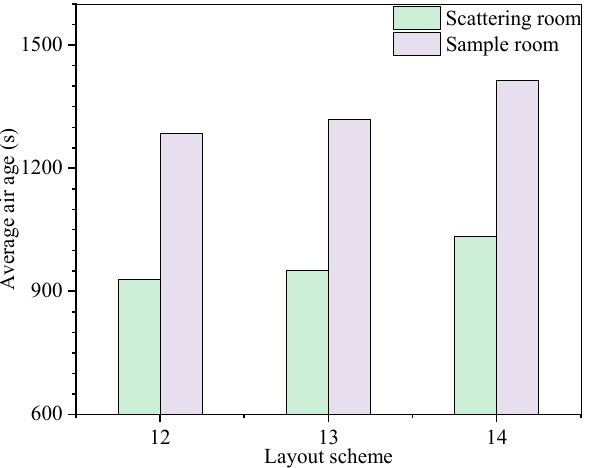
Figure 11. Comparison of average air age of three outlet heights (The scattering room z = 1.6 m and the sample room z = 2.4 m).